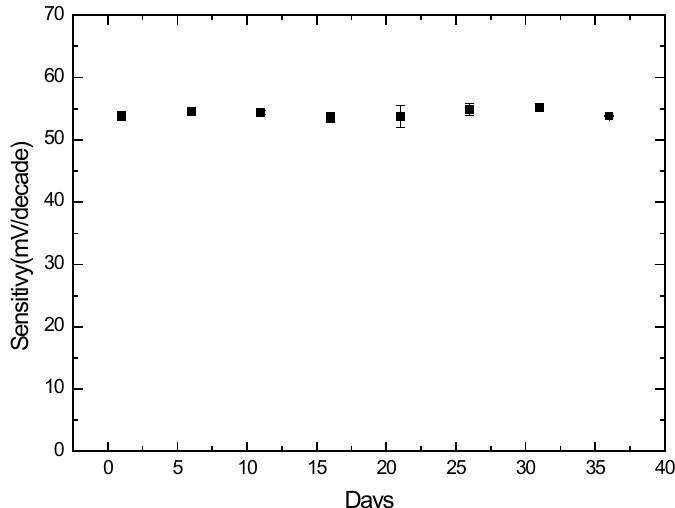
Figure 6. Sensitivities of the Ch sensor during 35